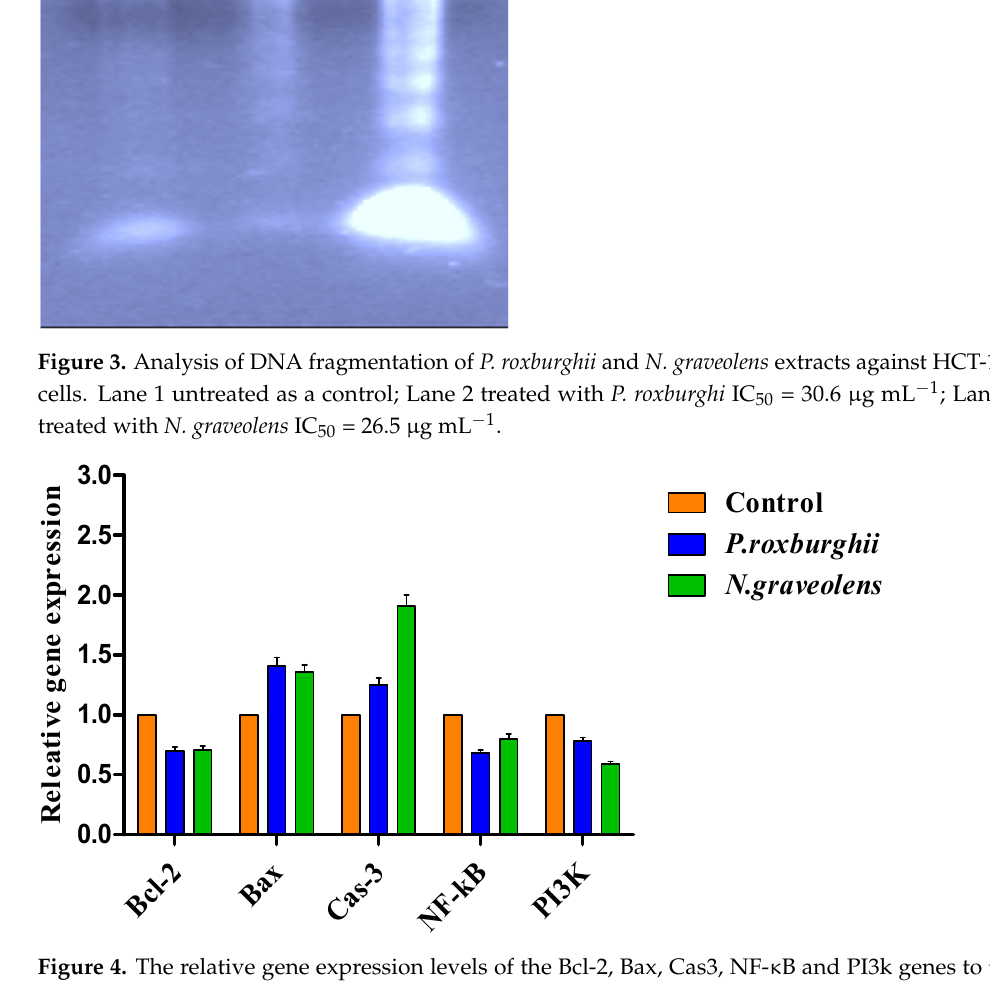
Figure 4. The relative gene expression levels of the Bcl ‐ 2, Bax, Cas3, NF ‐κ B and PI3k genes to the GAPDH gene on P. roxburghii and N. graveolens GAPDH gene on P . roxburghii and N . graveolens extracts.